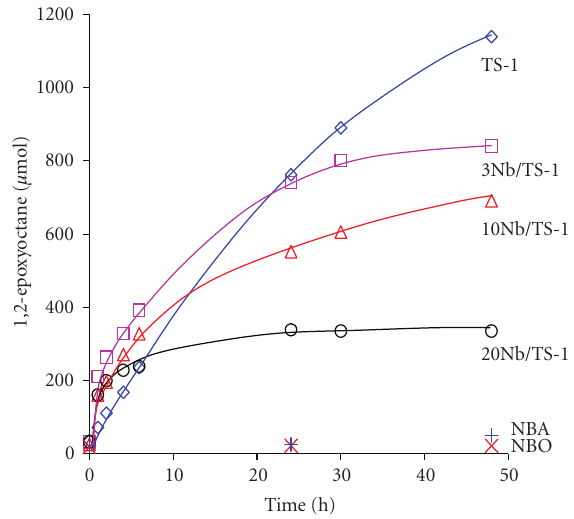
Figure 10: The formation of 1,2-epoxyoctane from 1-octene epoxidation using H 2 O 2 at 70 ◦ C catalyzed by NBA, NBO, TS-1, and X